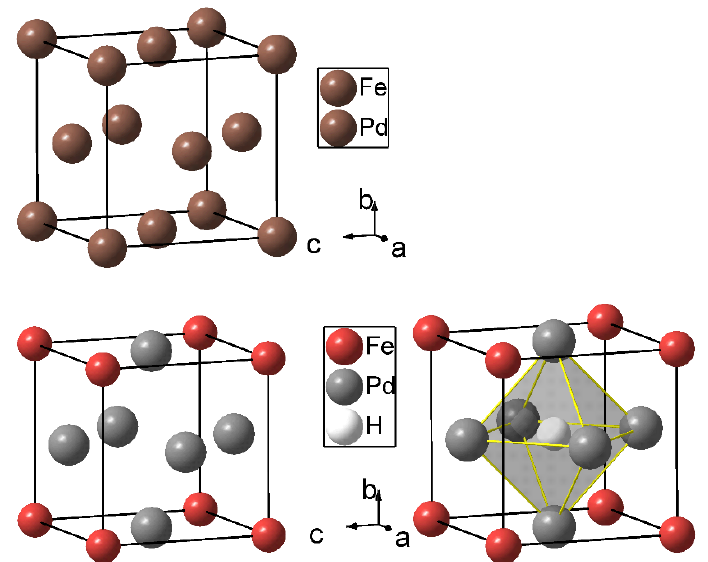
Figure 1. The crystal structures of FePd 3 in Cu type (left, disordered, Fe 0.25 Pd 0.75 , Fm 3 m [15]) and in AuCu 3 type (middle, ordered, FePd 3 , Pm 3 m [15]) and the crystal structure of FePd 3 H 0.05 in the cubic anti-perovskite type ( Pm 3 m (this work)) with hydrogen atoms surrounded by six palladium atoms in an octahedral arrangement.